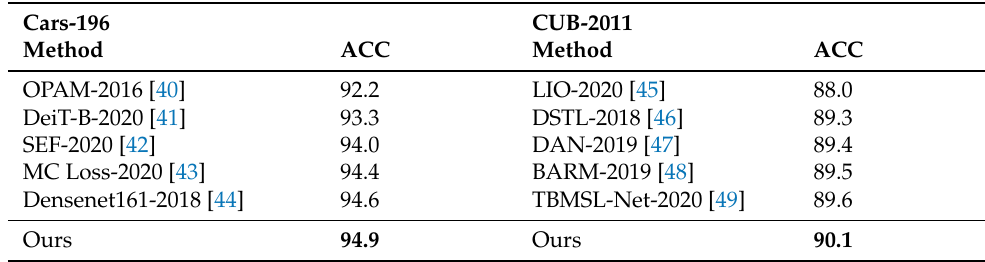
Table 4. Accuracy (%) comparison with the recent top-five state-of-the-art approaches on Cars-196 and CUB-2011. Our accuracy is significantly higher than baseline